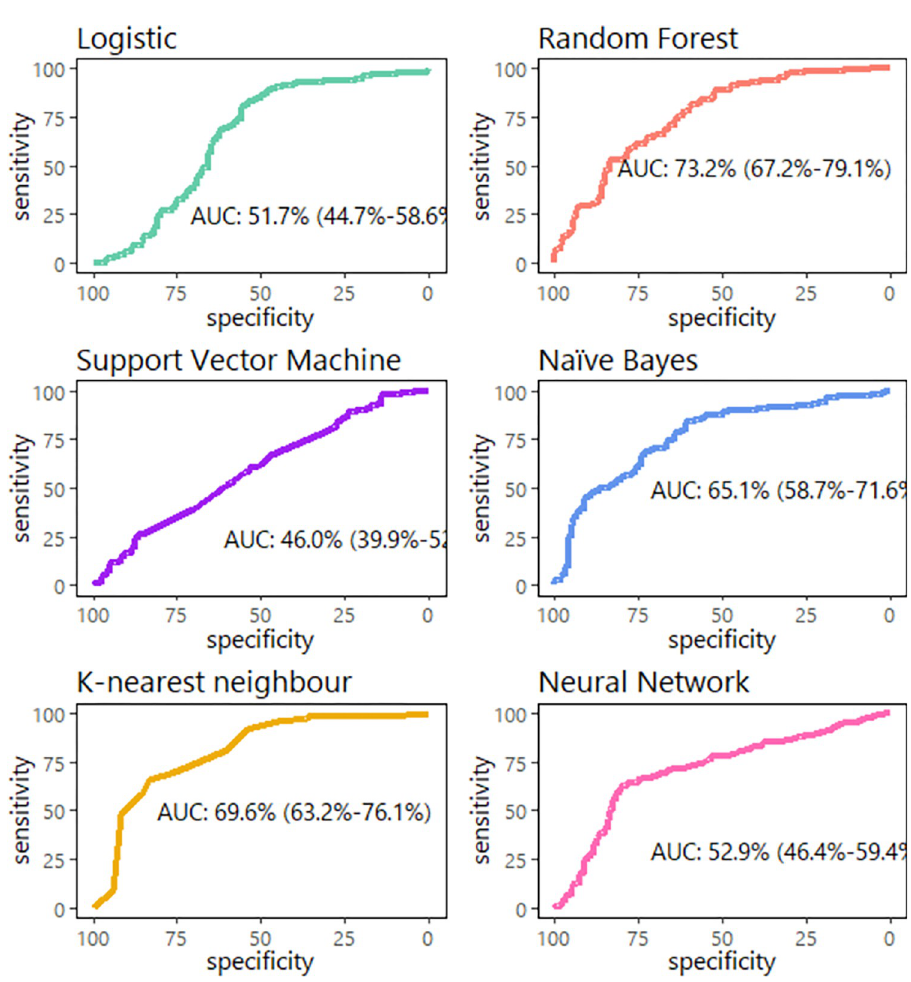
Fig 2. Algorithms receiving operating curve in the validation